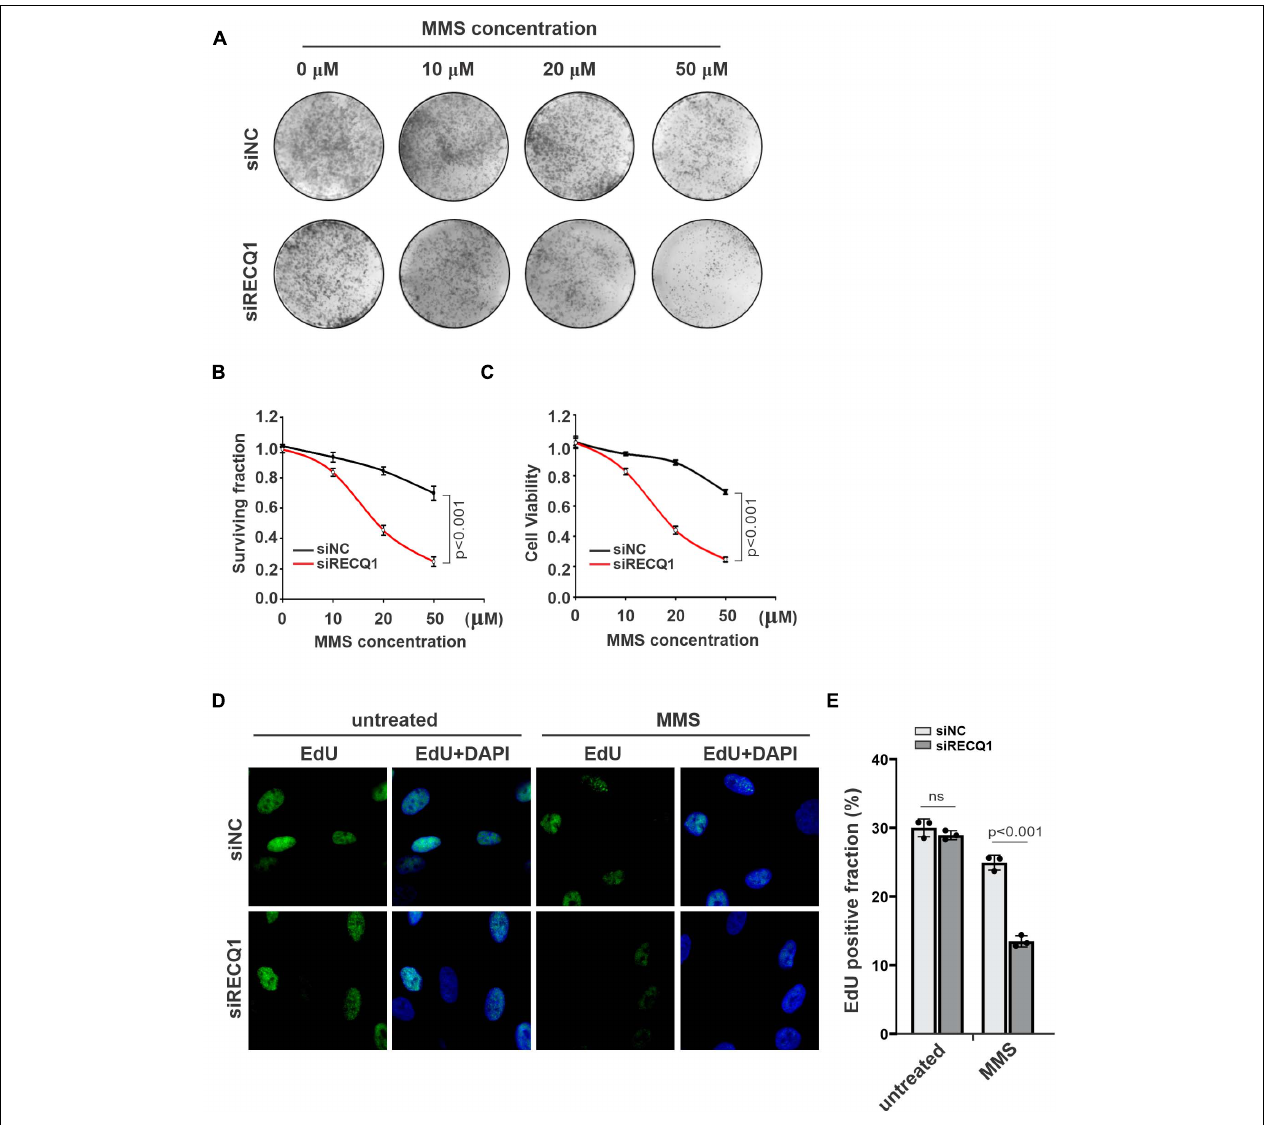
FIGURE 2 | RECQ1 depletion impaired GBM cells cellular progression. (A) Colony formation assay of M059K cells treated with different concentration of MMS after transfection with siNC or siRECQ1. Representative images are shown. (B) Quantification are represented as means ± SD from at least three independent experiments. (C) The viability of siRECQ1 transfected M059K cells was measured with a CCK8 kit. Data are represented as means ± SD from at least three independent experiments. (D) Cell proliferation was measured by an EdU labeling of immunofluorescence. (E) Quantification are represented as means ± SD from at least three independent experiments. A two-sided unpaired t -test was used to calculate P -values. Significant: p < 0.05; NS, not significant: P >